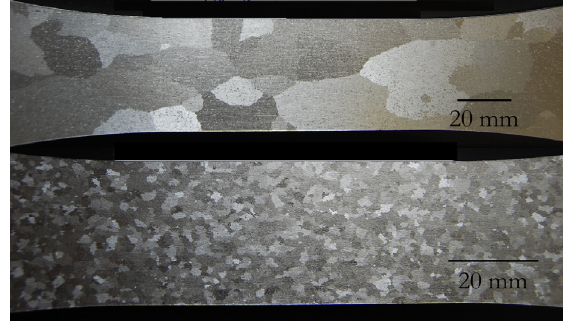
Figure 1: Microstructure obtained depending on the degree of applied